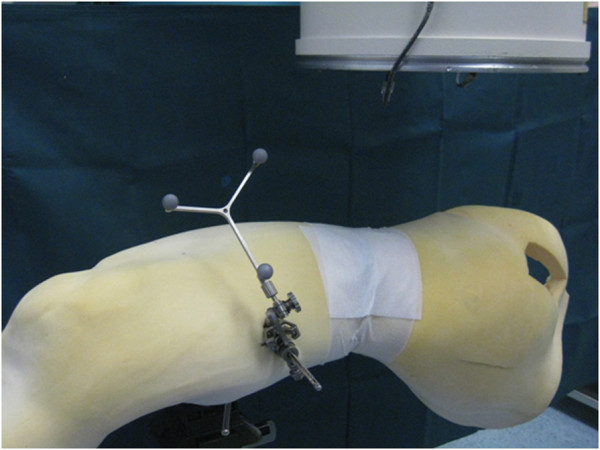
Foam-coated synthetic femur with mounted reference base.